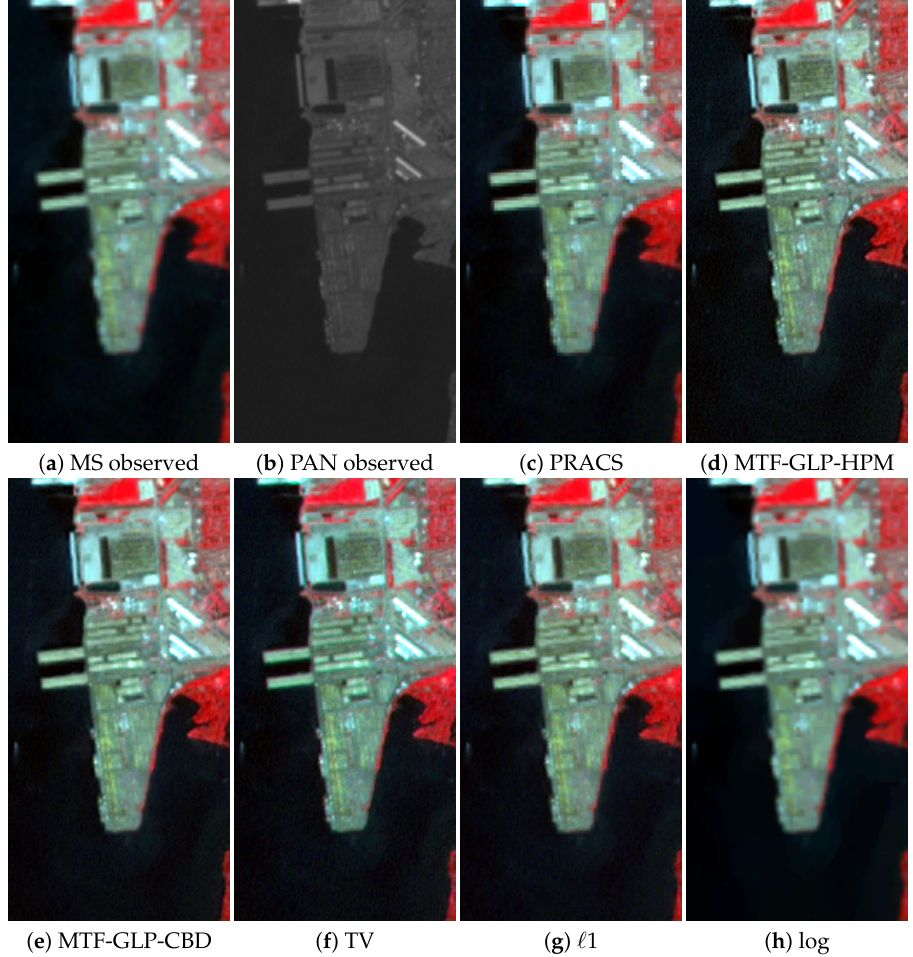
Figure 7. A region of interest of the LANDSAT 7-ETM+ Chesapeake Bay image in Figure 1a. Observed images: ( a ) 128 × 64 MS, ( b ) 256 × 128 PAN. 256 × 128 pansharpened images by: ( c ) PRACS, ( d ) MTF-GLP-High Pass Modulation (HPM), ( e ) MTF-GLP-CBD, ( f ) TV, ( g ) (cid:96) 1 and ( h ) log